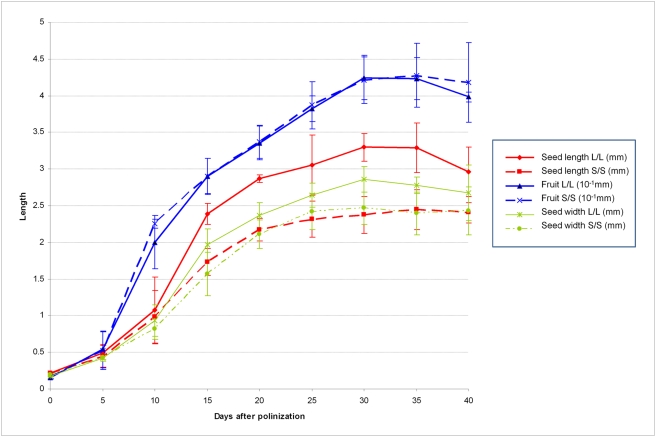
Plots for developmental changes in fruit length, seed width and seed length for the L/L and S/S NILs.Bars indicate the standard errors.